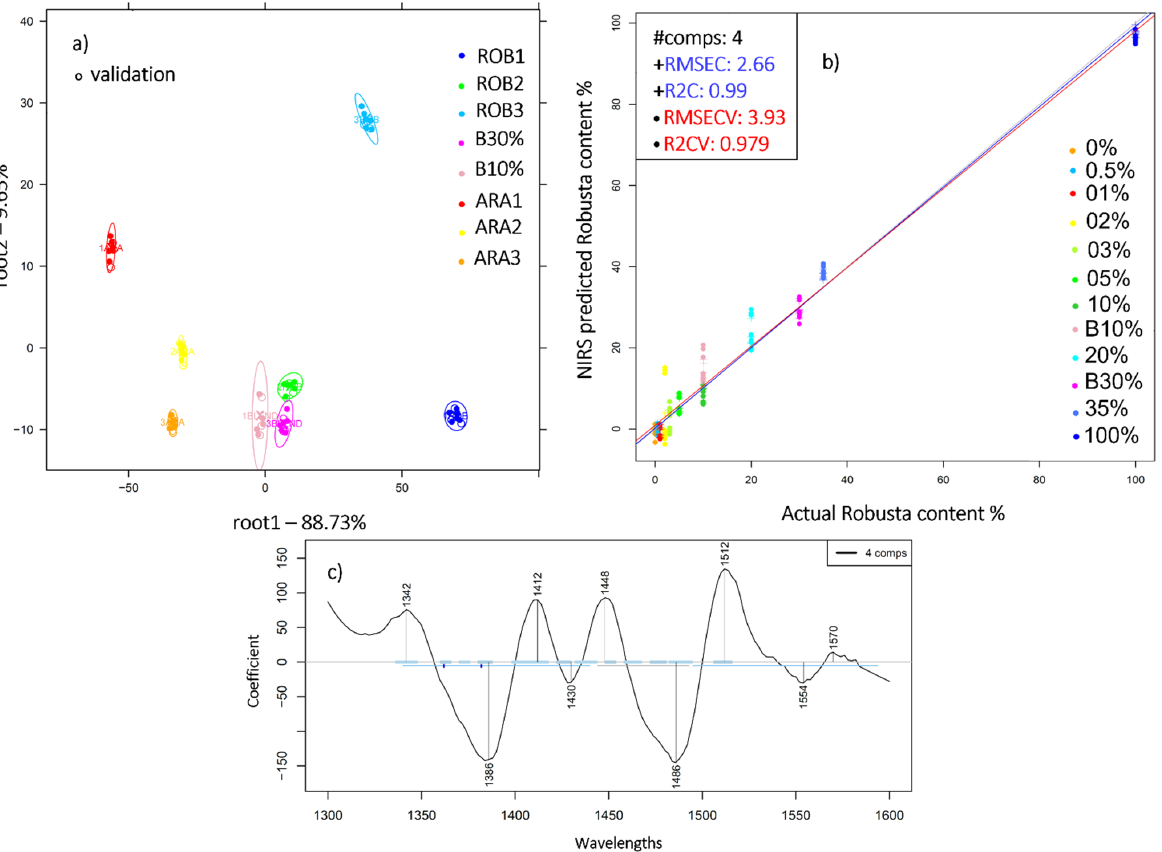
Figure 4. ( a ) PCA-LDA Classification of pure ground Arabica (ARA1, ARA2, ARA3), Robusta (ROB1, ROB2, ROB3) and marketed blends B10%, B30% in the range 1300–1600 nm, N = 72, spectral pretreatment: Savitzky-Golay smoothing (window size 19) and 1st derivative; ( b ) PLSR analysis of the ground coffee mixtures and B10% and B30%, spectral pretreatment: Savitzky-Golay smoothing (window size 17) and SNV; ( c ) The respective regression vector in the 1300–1600 nm.